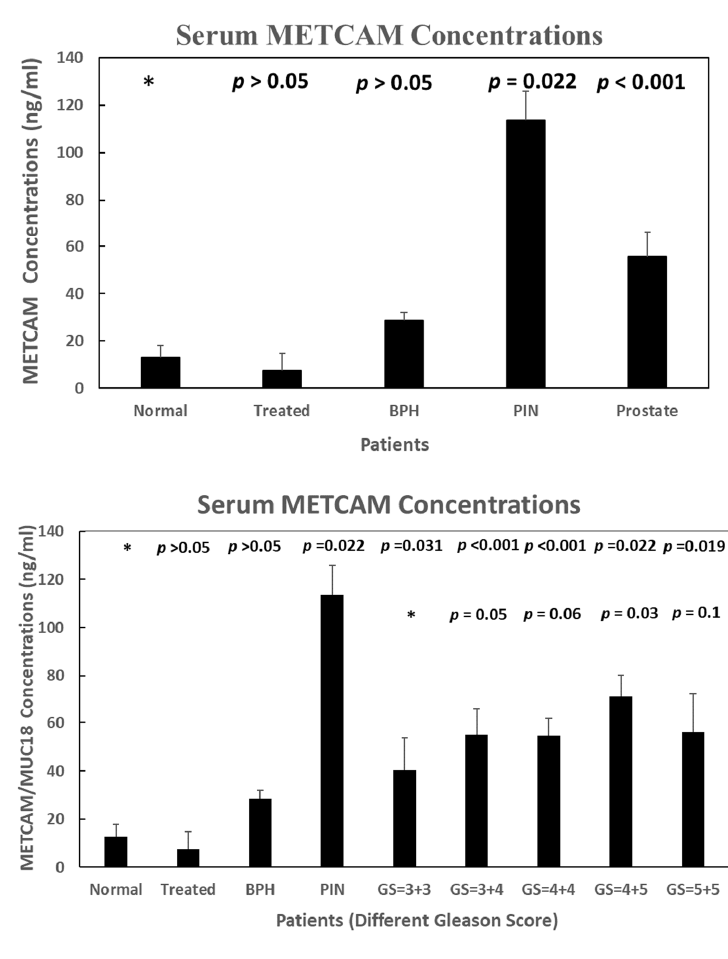
Figure 8. Serum METCAM concentrations in normal individuals and patients with BPH, PIN, prostate cancer at different Gleason scores (GS), and treated as determined by the direct application of the triple complexes to the modified LFIA [41,44,45]. ”*” is the reference data for statistical analysis. Table 1. Comparison of various immunological detection methods.